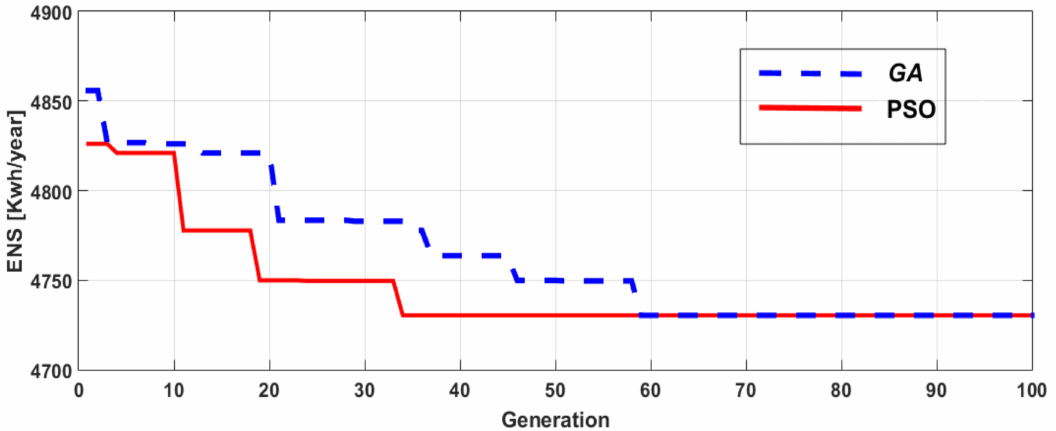
Figure 9. GA and PSO convergence characteristic for the minimization of the ENS criterion.